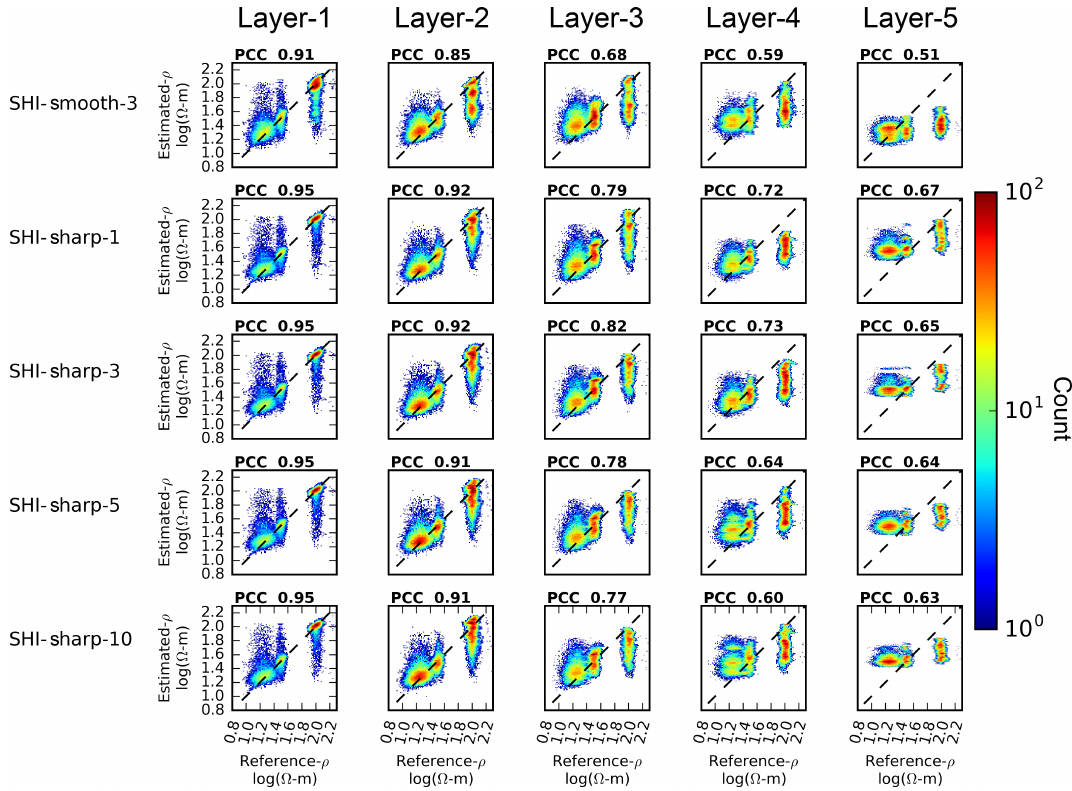
Figure 5. Scatter plot of true and estimated electrical resistivity fields for smooth geophysical inversion and sharp geophysical inversion for different data qualities of the AEM data for model realization number 20. On top of each window a Pearson correlation coefficient (PCC) is